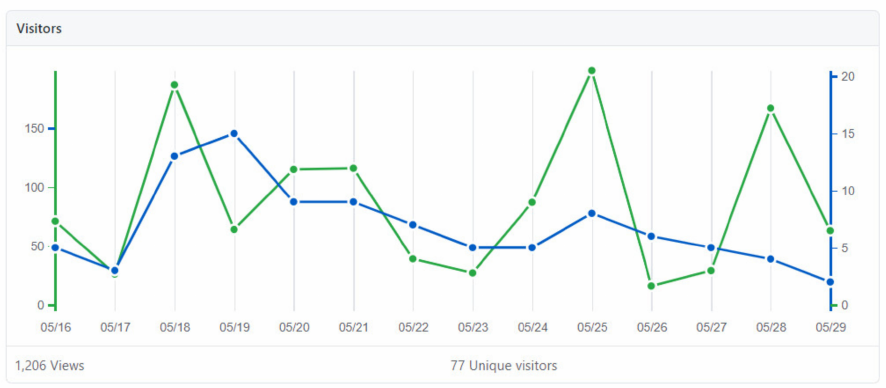
Figure 8. Number of unique visitors of COVID-19 Data repository for past 14